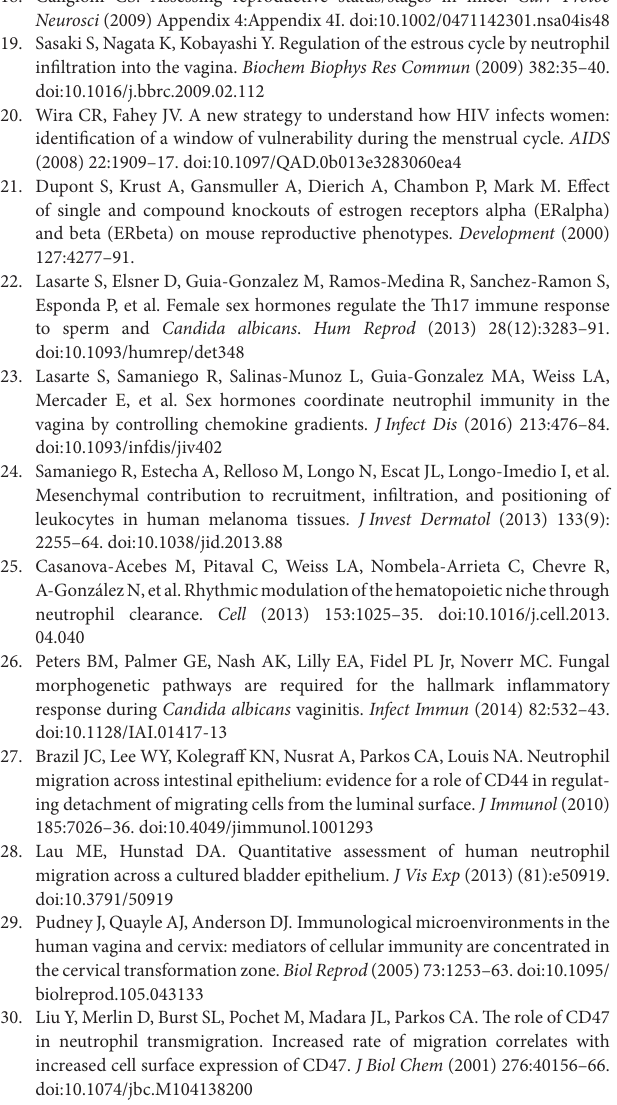
anatomical region sections were LY6G-stained neutrophils (white). (B) LY6G + cells/field in the indicated areas of the FRT epithelium and stroma. Data were calculated in at least three different sections of endocervix or uterus or vagina ( n = 5) and are expressed as box and whiskers 10–90 percentile ( n = 8 to 10 mice per time points). ns, no significant; * p < 0.05, ** p < 0.01, *** p < 0.001, Mann– Whitney. Scale bar, 200 µm. Yellow line indicates the lamina propia. Abbreviations: E2, estradiol; P4, progesterone; Lu, lumen; Ep, epithelium; St, stroma. FigUre s3 | Hormone treated ovariectomized mice were mock Candida albicans inoculated in the vagina. (a) Vaginal epithelium stained for CD47 (red) or neutrophils (white). CD47 expression in the basolateral epithelium. Data were calculated in at least three different points in three different sections of each sample ( n = 5). (B) Vaginal epithelium CD44-stained (red) and LY6G-stained neutrophils (white). CD44 expression in the apical epithelium. Data were calculated in at least three different points in three different sections of each sample ( n = 5). Data are expressed as box and whiskers 10–90 percentile. *** p < 0.001 Mann–Whitney. (c) Female reproductive tract indicated anatomical regions CD55 stained ( n = 3). Scale bar, 200 µm. Yellow line indicates the lamina propia. Abbreviations: E2, estradiol; P4, progesterone. Lu, lumen; Ep, epithelium; St,